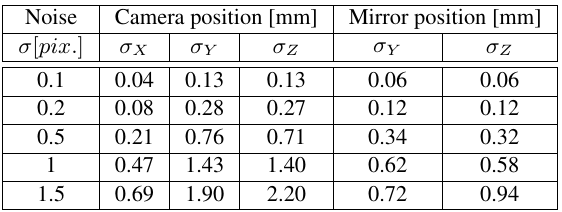
The X -shaped point arrangement offers an even distribution in γ along two planes of reflection (Fig. 2b). 2 Estimates for the resec- tion model are listed in Table (3), showing some improvement in the accuracy but not on a significant level, with a nearly similar condition number 832.